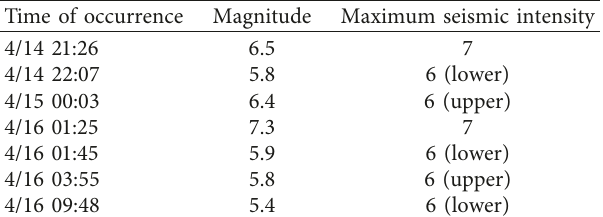
Table 1: Time of occurrence, magnitude, and maximum seismic intensity